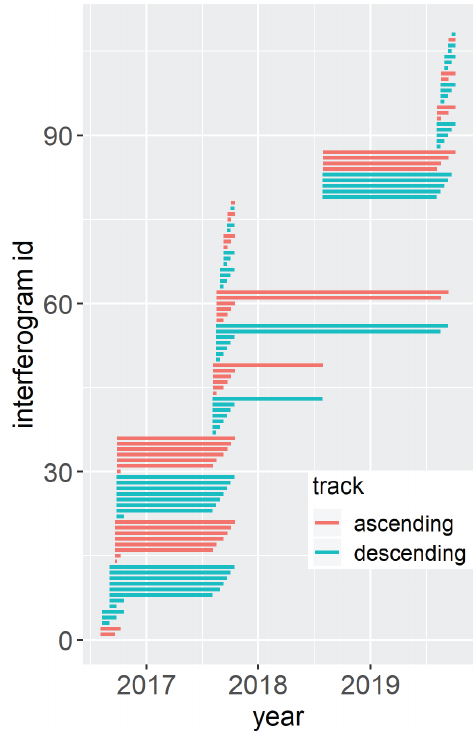
Figure A1. Temporal distribution of interferograms. Interferograms were generated using Sentinel 1 IW SLC (single look complex) scenes. Interferogram pairs were chosen based on snow-free peri- ods. Red and blue lines represent ascending and descending inter- ferograms,